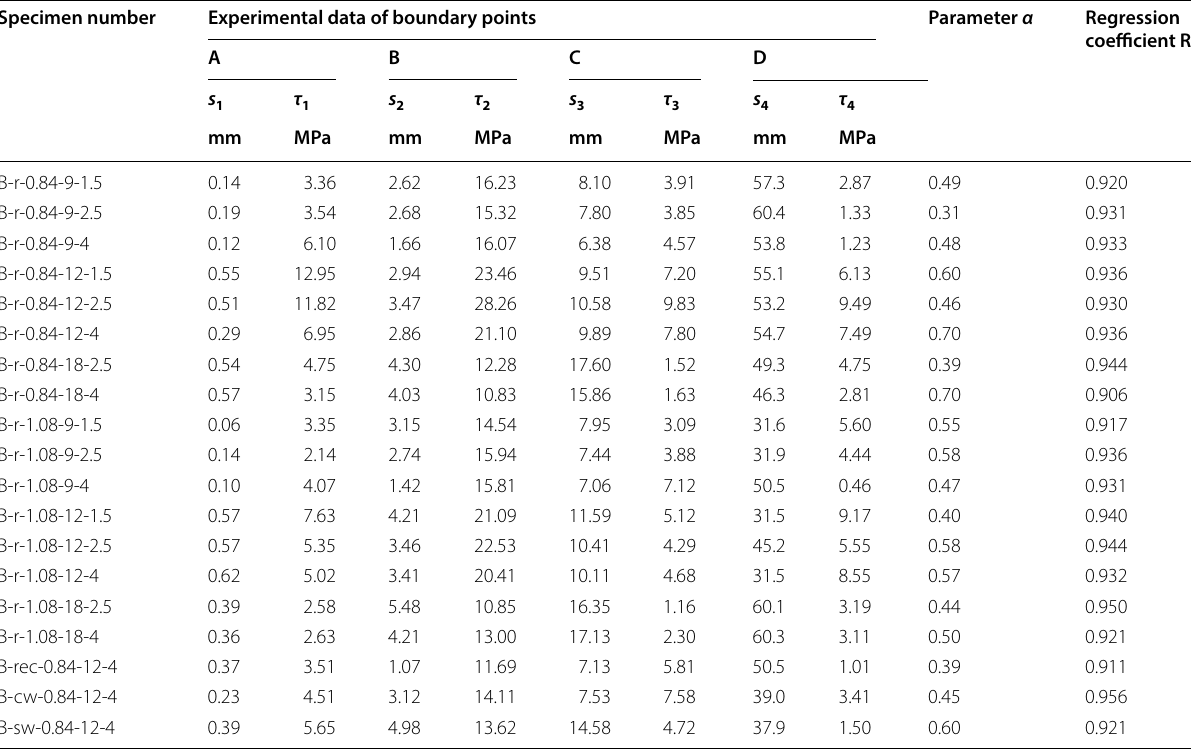
Table 6 Data of boundary point and fit value of parameters. Specimen